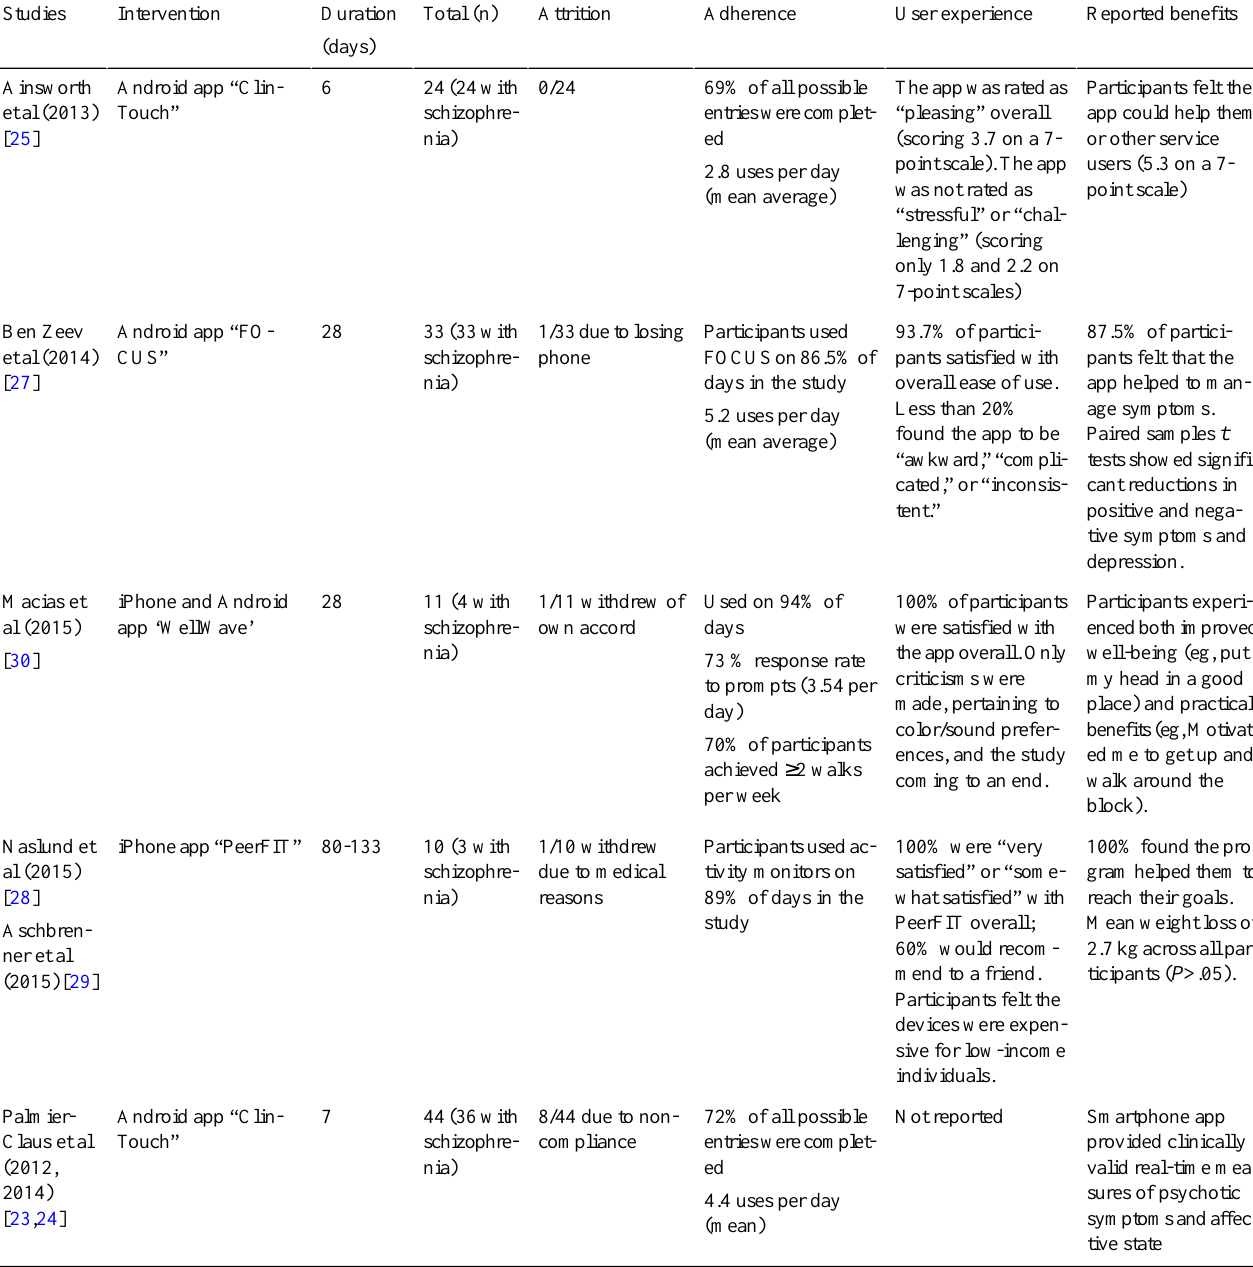
Table 1. Studies of smartphone apps for people with schizophrenia.